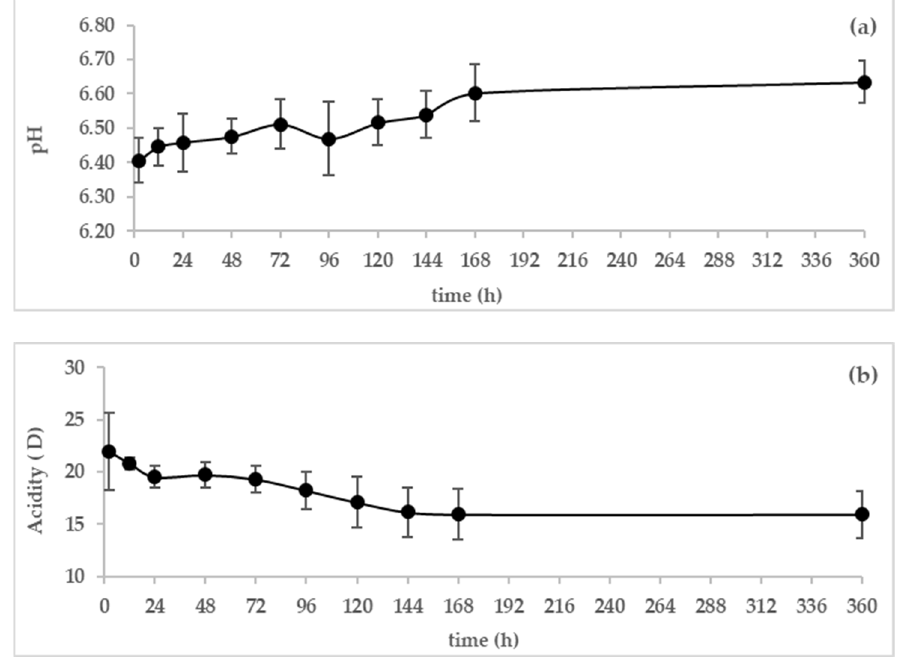
Figure 1. Variation in pH ( a ) and acidity ( b ) of dromedary camel colostrum and milk during the first 7 days and on day 15 postpartum ( n = 16).